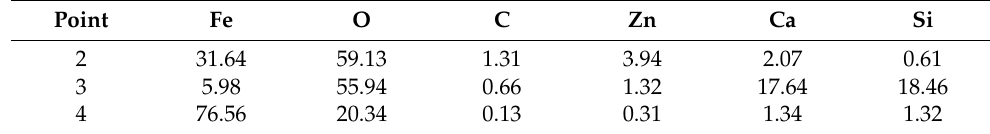
Table 2. EDS results analysis of points 2–4 in Figure 6c, (atomic percent) %.